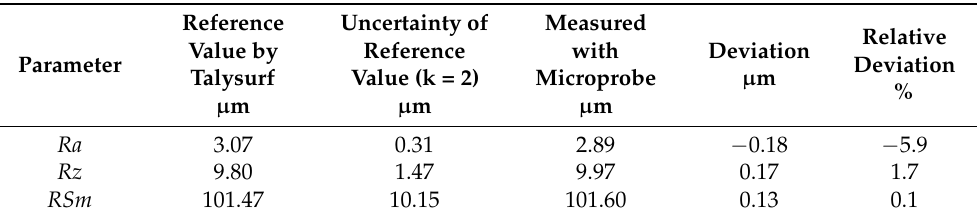
Table 1. Comparison of Ra , Rz and RSm parameters for a type 178-601 surface roughness standard measured with the Talysurf and the microprobe setup in the laboratory.